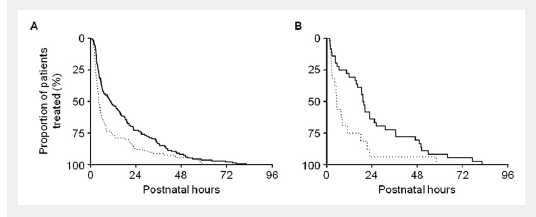
Kaplan-Meier estimates of the time between birth and the first dose of antibiotics in: (A) all infants treated for suspected early-onset neonatal sepsis during Period 1 (full line, n = 132) and Period 2 (dotted line, n = 90), p <0.001; (B) infants with neonatal infection during Period 1 (full line, n = 36) and Period 2 (dotted line, n = 16), p